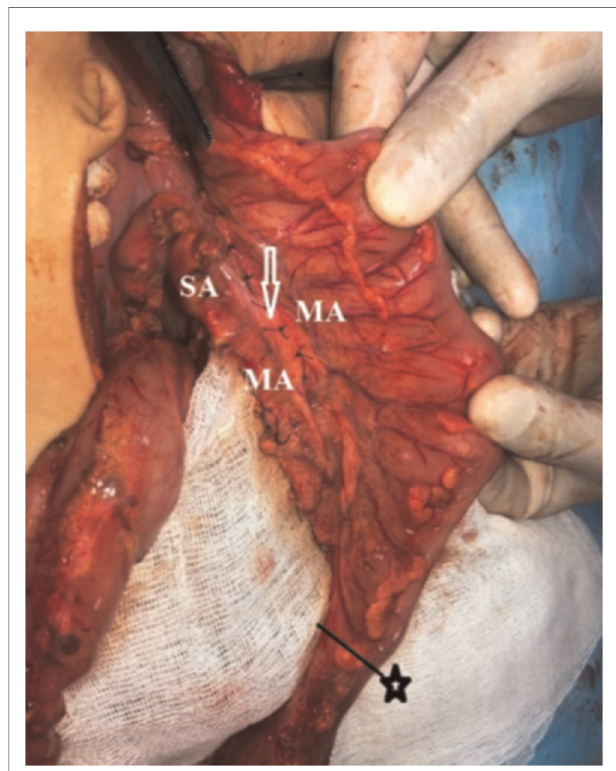
FIGURE 3 | MA, marginal artery; SA, sigmoid arteries. The lengthening of the sigmoid arteries occurs due to the mobilization of the marginal artery. The arrow indicates the peritonization of the “ window ” . ★ — border of colon resection.